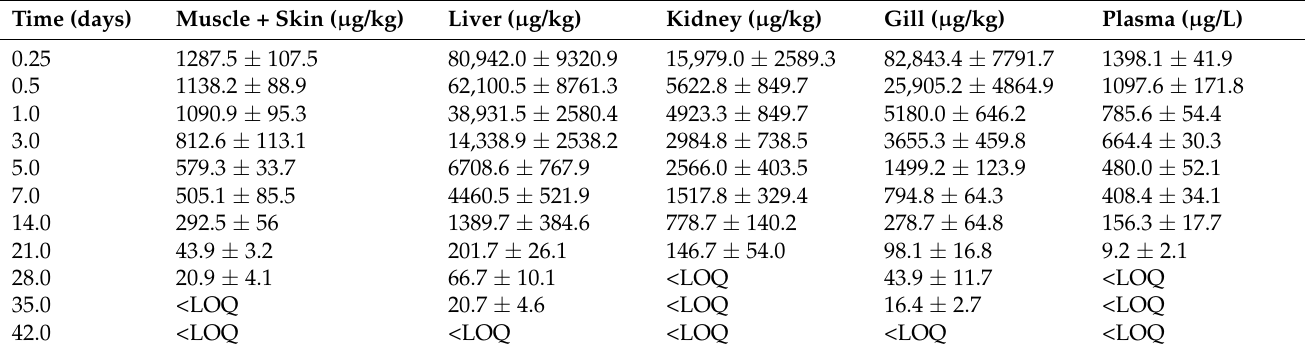
Table 2. The concentrations of doxycycline in muscle + skin, liver, kidney, gill, and plasma of yellow catfish ( Pelteobagrus